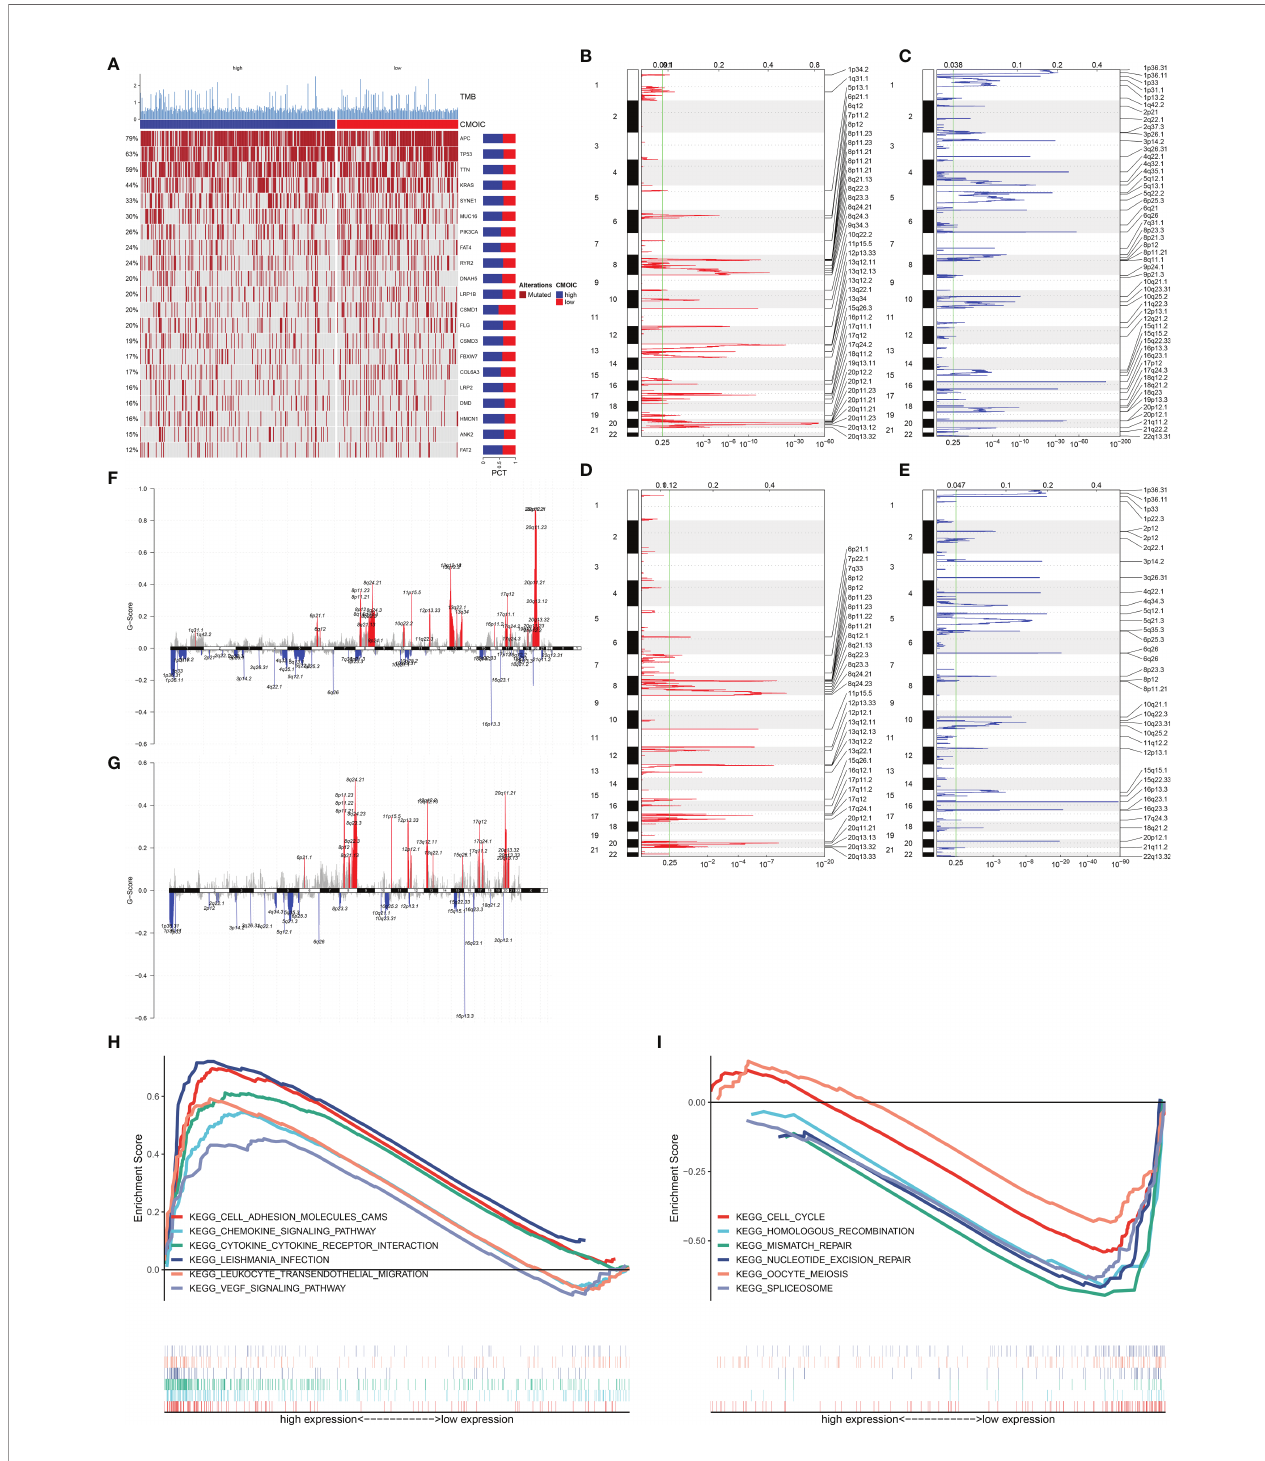
FIGURE 5 | Association of EVA1B with mutational landscape and signaling pathways in CRC individuals. (A) Landscape of somatic mutation in high and low EVA1B expression CRC subpopulations. Genes are ranked following the mutational frequency. Upper portion of the chart displays TMB score of each patient. (B, C) Landscape of (B) ampli fi cation and (C) deletion in high EVA1B expression subpopulation. (D, E) Landscape of (D) ampli fi cation and (E) deletion in low EVA1B expression subpopulation. The genome is oriented vertically from top to bottom; GISTIC2.0 q -value at each locus is depicted from left to right. The green line indicates the cutoff value of q -value = 0.25. (F, G) Detection and comparison of ampli fi cation and deletion of copy number in high and low EVA1B expression subpopulations. (H) GSEA for the signaling pathways activated in high EVA1B expression subpopulation. (I) GSEA for the signaling pathways activated in low EVA1B expression